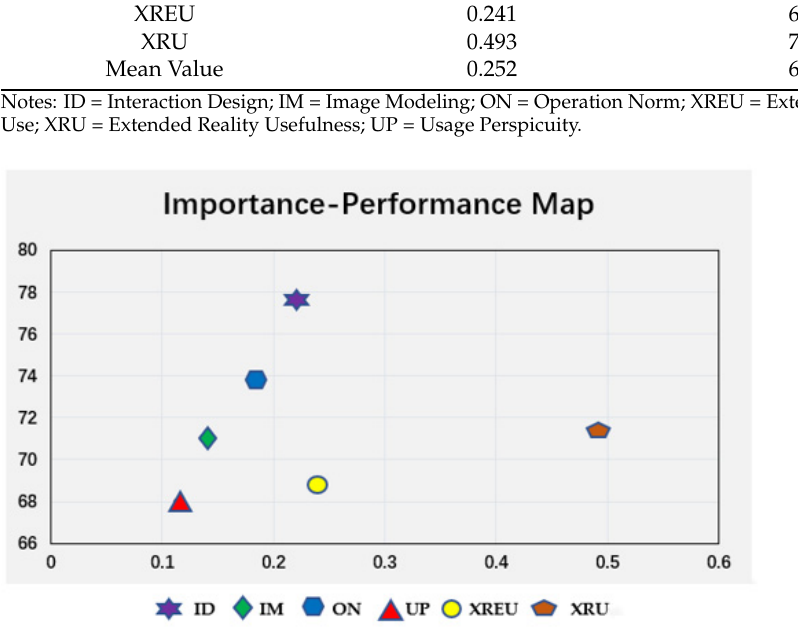
Figure 4. XRTBM for